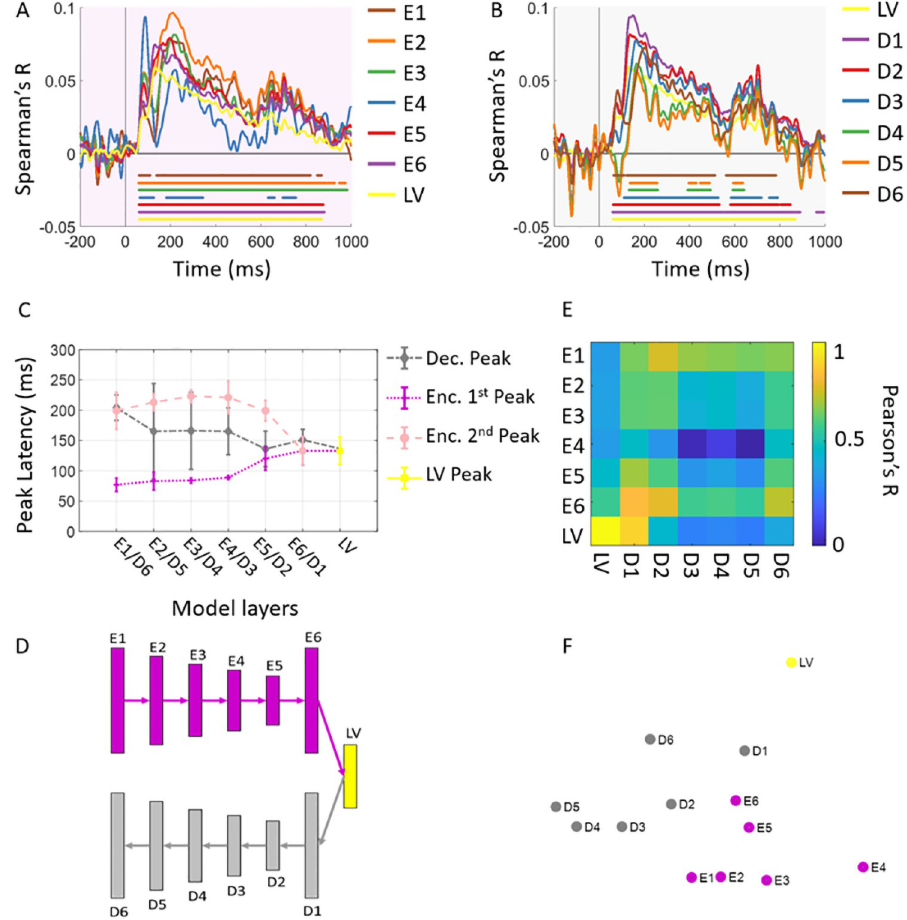
Fig 5. Temporal representational comparisons. (A) Encoder and MEG representational comparison. We correlated the encoder layer RDMs with subject-specific time-resolved MEG RDMs resulting in fifteen correlation time courses. We then averaged these time courses over participants. (B) Decoder and MEG representational comparison. Correlation of the decoder layer RDMs and time-resolved MEG RDMs. The color-coded lines below the curves show the time points when the correlations are significantly above zero (N = 15; permutation tests; cluster definition threshold P < 0.01; cluster threshold P < 0.05). (C) Peak latency for encoder and decoder. The encoder have significantly earlier peak latency across all layers ( P = 0.014). Error bars are expressed in standard error of the mean. (D) The architecture of the models with layers’s label corresponding to (C). (E) The visualization of relationships between model layers representations. The matrix of RDM correlations between encoder and decoder layers is depicted. Each matrix entry compares two RDMs indexed by corresponding row and column in terms of Pearson’s R. (F) The multidimensional scaling visualization of the RDMs